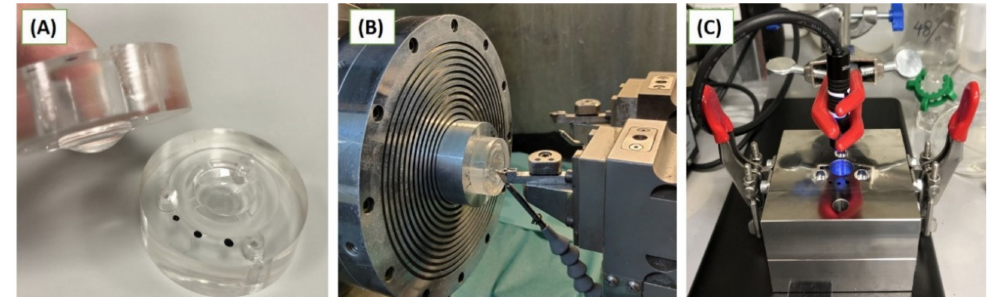
Figure 1. Aspheric COC mould ( A ), SPDT of optical mould ( B ) and moulding system including COC mould and UV light source ( C